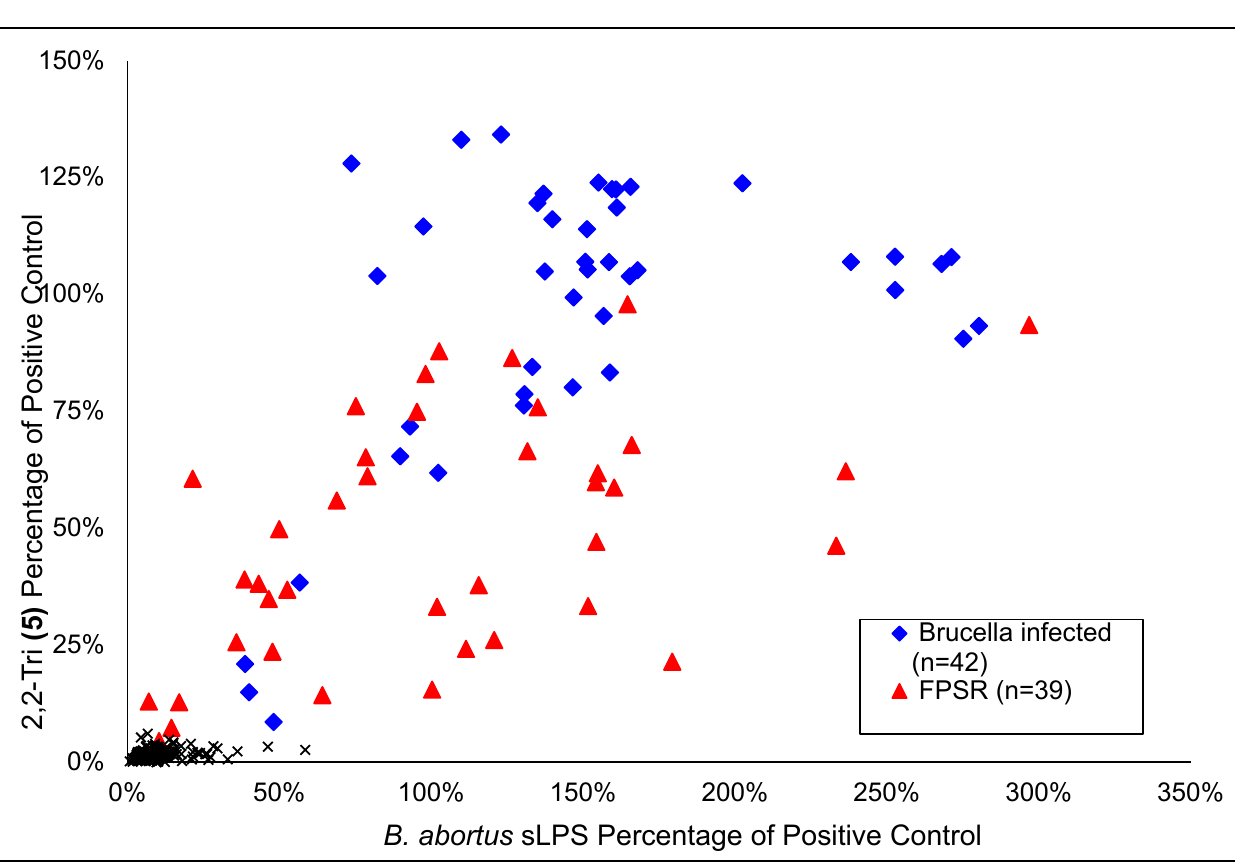
Figure 5. A scatter plot showing ELISA results using B . abortus S99 sLPS antigen on the x -axis and the 2,2-Tri (5) antigen on the y -axis. The results for three field sample populations are shown: sera from B. abortus infected cattle ( n = 42), blue diamonds; FPSR cattle sera ( n = 39), red triangles; and sera from randomly sampled cattle from GB an OBF country ( n = 240), black crosses.